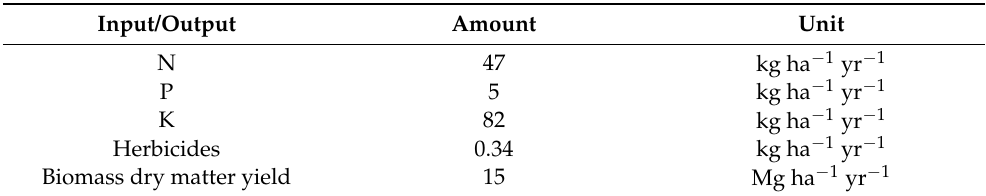
Table 2. Main inputs and outputs of miscanthus cultivation per year (adapted from Winkler et al. (2020)